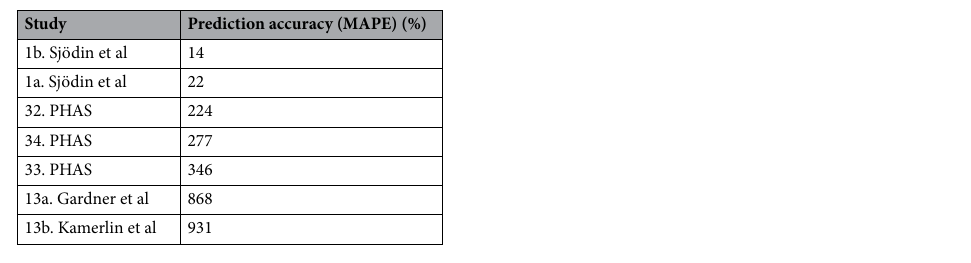
Table 2. Comparison of model accuracy for models that predicted the ICU-occupancy in Stockholm Region during the first wave of the pandemic in